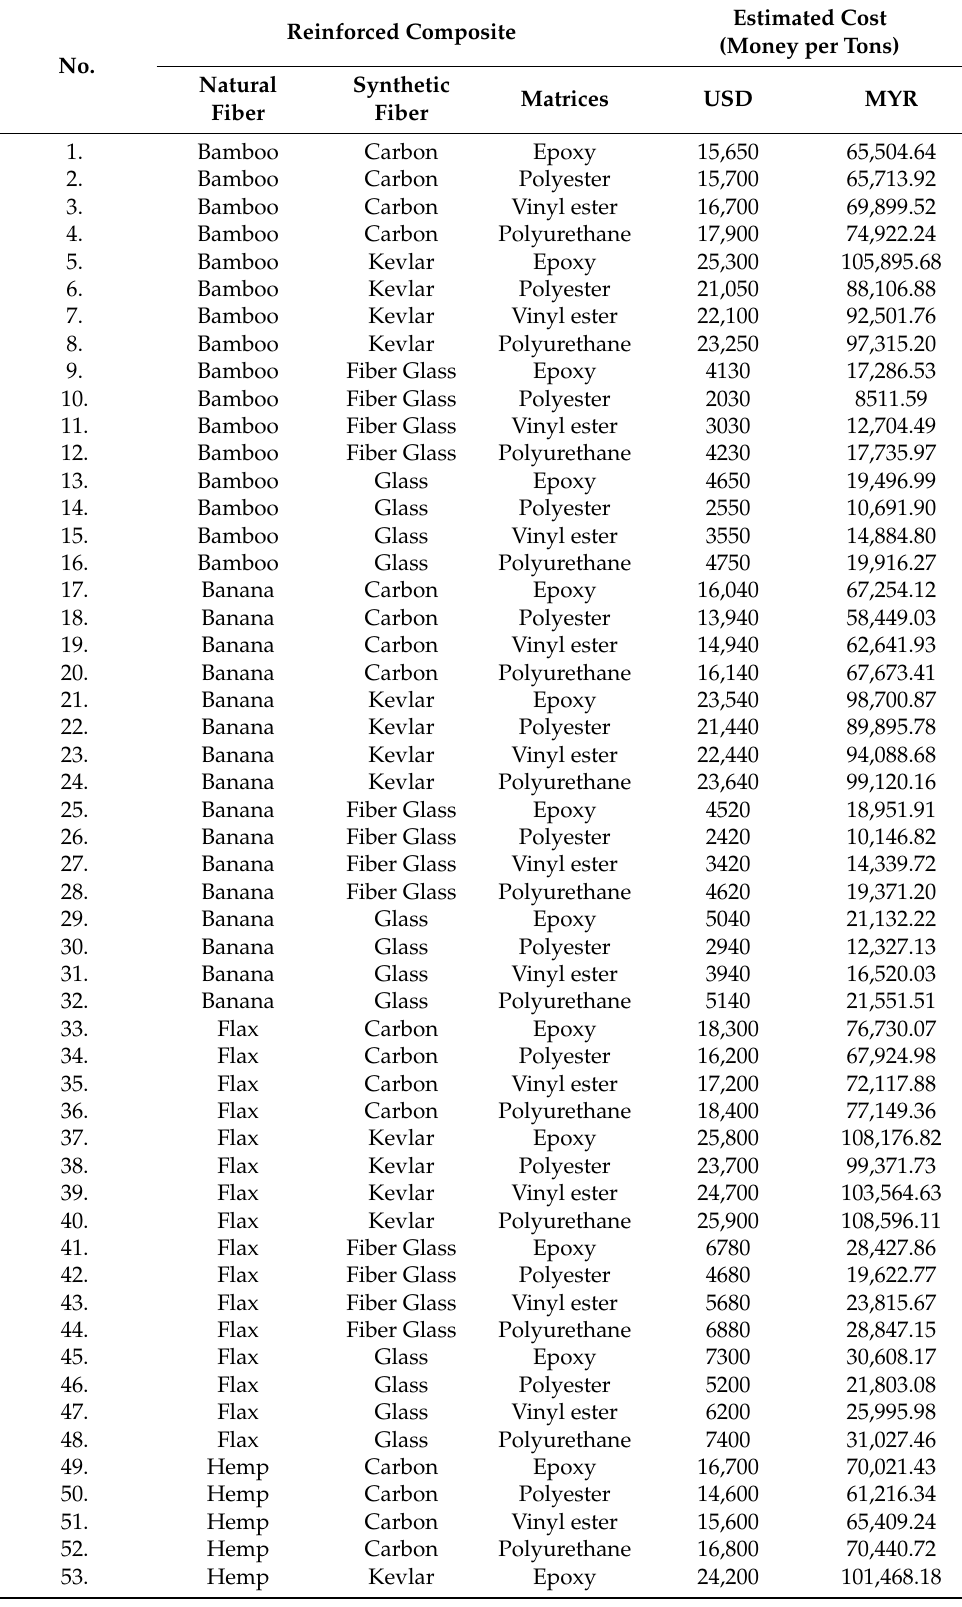
Table 6. Estimated costing for NF as reinforcement in hybrid composites (in US Dollar/USD and Malaysia Ringgit/MYR)